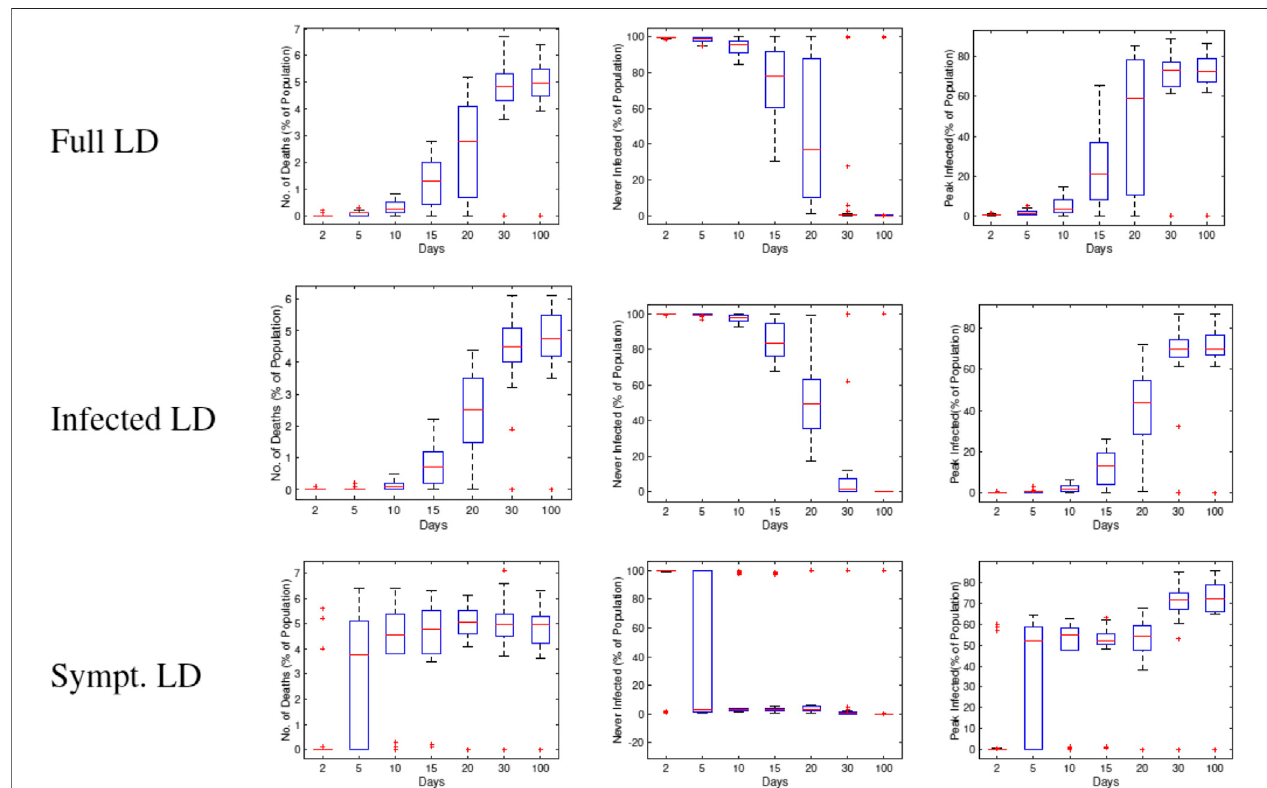
FIGURE 14 | Statistical summaries of infection variables obtained using 30 runs of RAW-ALPS, plotted against the starting day of the lockdown. In all three lockdown types, a delay in imposing lockdown causes an increase in infections and casualties.